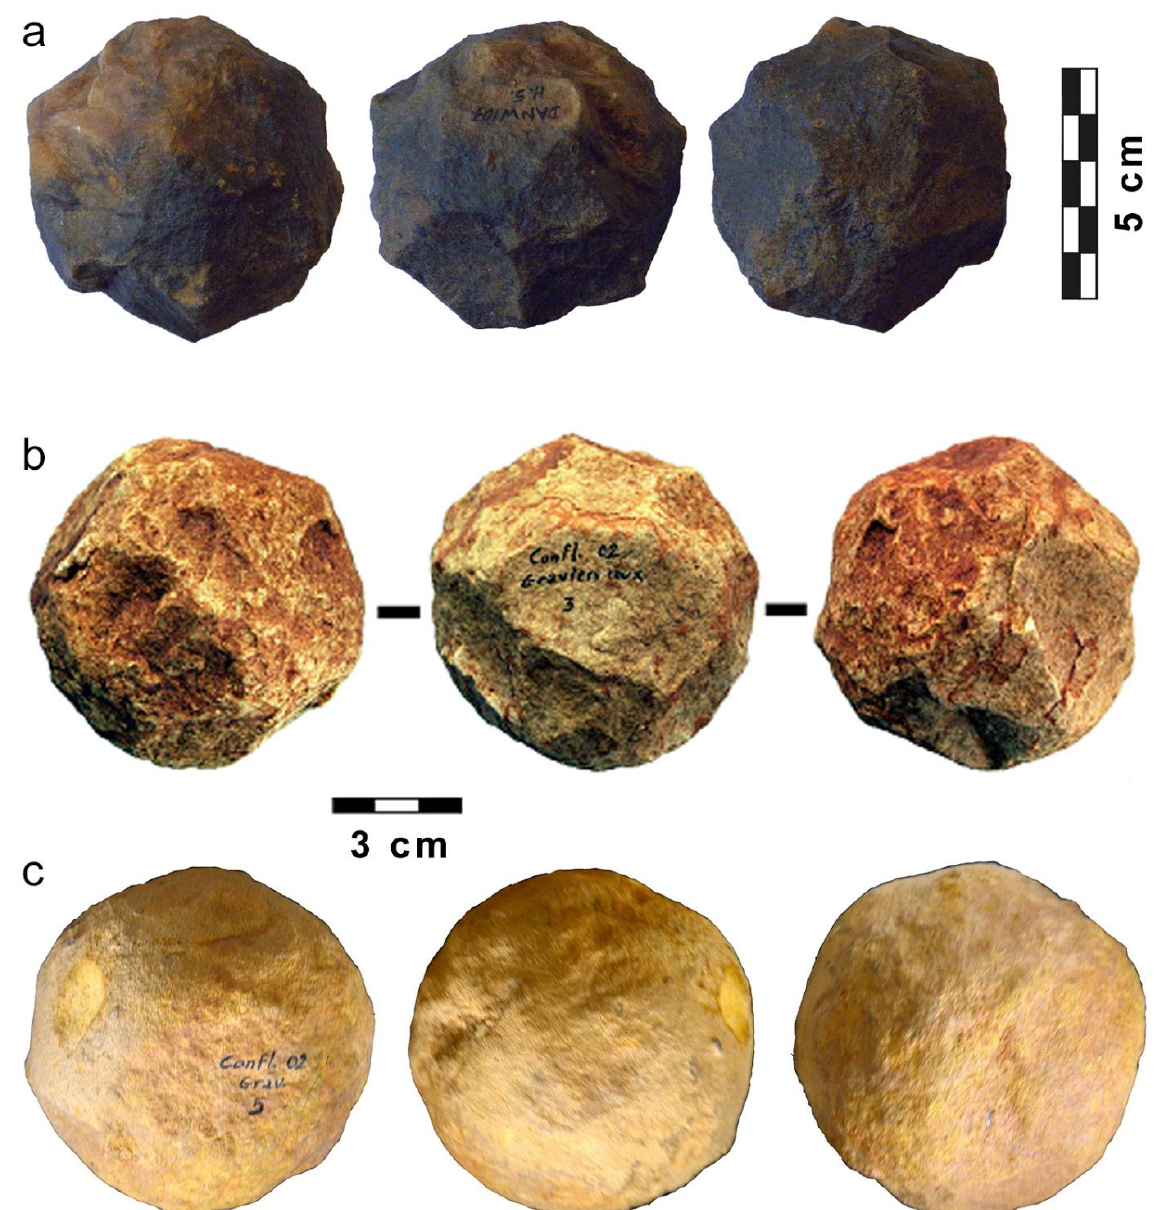
Figure 13. Tools on spheroids and bolas. a. pointed spheroid; b. faceted spheroid; c.